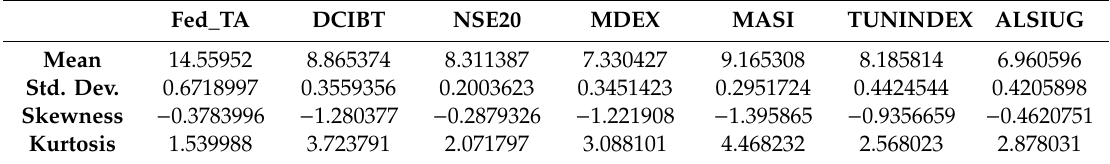
Table 1. Descriptive statistics regarding the Fed’s total assets and the returns of the African stock indices. DCIBT NSE20